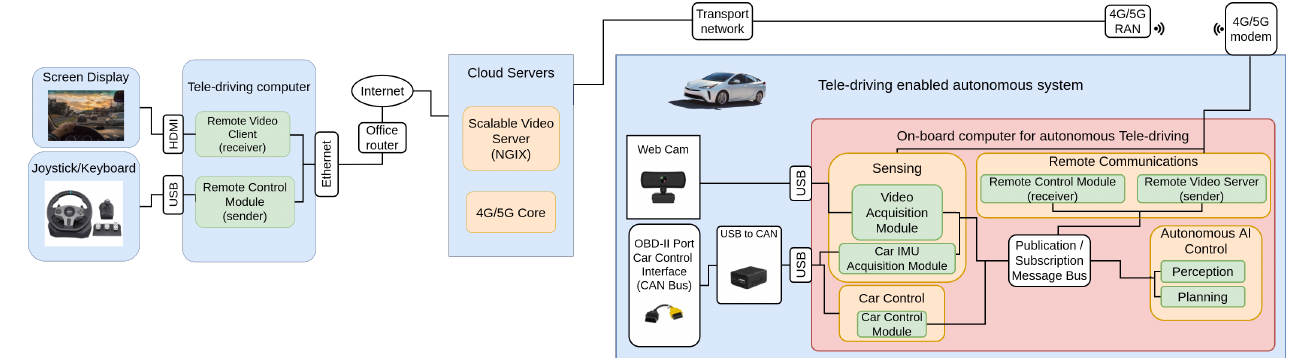
Figure 1. Proposed architecture for the tele-operation